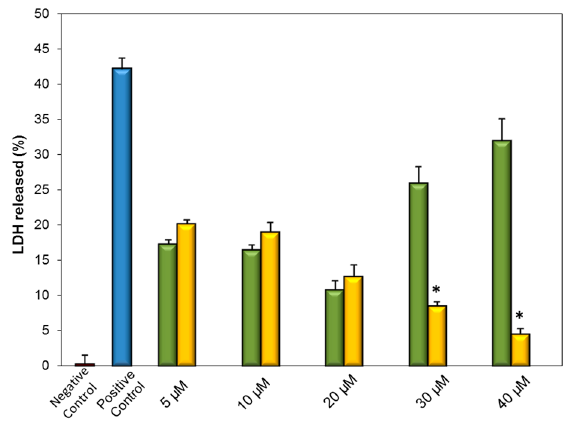
Figure 19. Protective effect of different concentrations of free (green bar) and complexed (yellow bar) IDE on U373 cells against hydrogen peroxide damage. Cells were treated with free and complexed IDE for 24 h; then, they were incubated with hydrogen peroxide for 1 h. LDH release was assessed as described in the Section 2. Results are presented as the means of three different experiments (six replicates for each point) ± standard deviation; * different from free IDE ( p < 0.05).